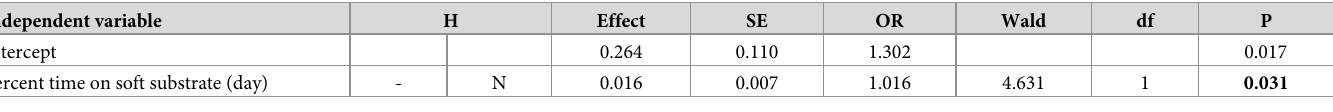
Table 15. Multivariate Poisson regression of factors associated with the number of lameness/stiffness events experienced by individual elephants that experienced at least one event (n = 80). Hypotheses (H): positive (+) or negative (-) relationship of each variable with the number of clinical events per animal as a measure of elephant welfare, and whether observed relationships were in the predicted direction (Y yes / N no).